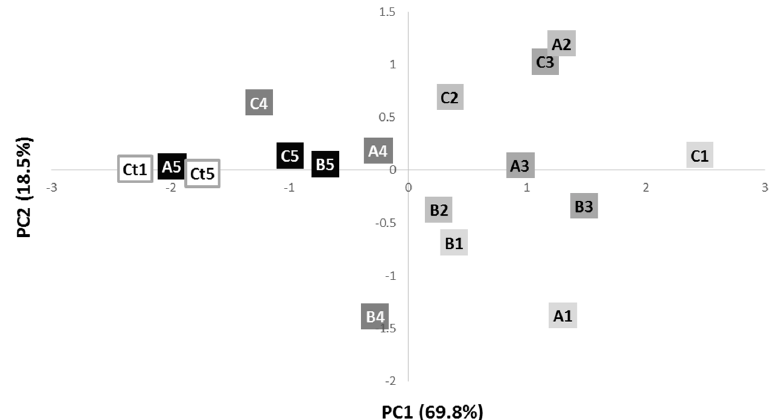
Figure 2. Scores scatter plot of the IR spectra of phage-resistant colonies A, B and C, along the 5 streak plating steps, and control phage sensitive colonies after 1 (Ct1) and 5 (Ct5) streaking steps. The letters correspond to the different colonies (A is colony A; B is colony B; C is colony C) and the numbers to the streaking-plate days (1 is day 1; 2 is day 2; 3 is day 3; 4 is day 4; 5 is day 5).